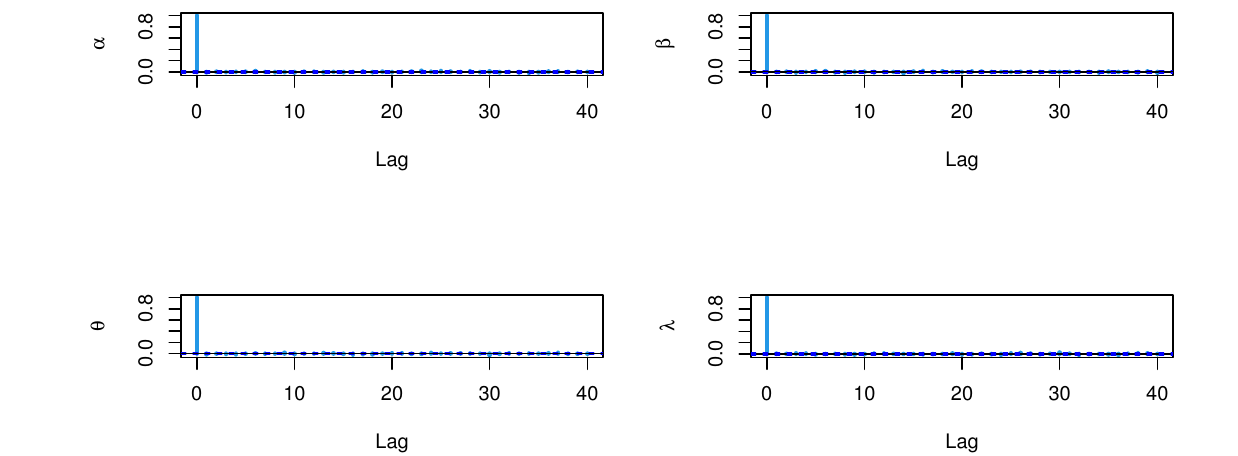
Figure 16. ACF test plots for parameters of TLMW model for Guinea Pigs